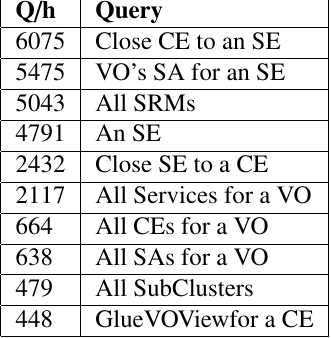
Table 1. Top ten queries from 2007